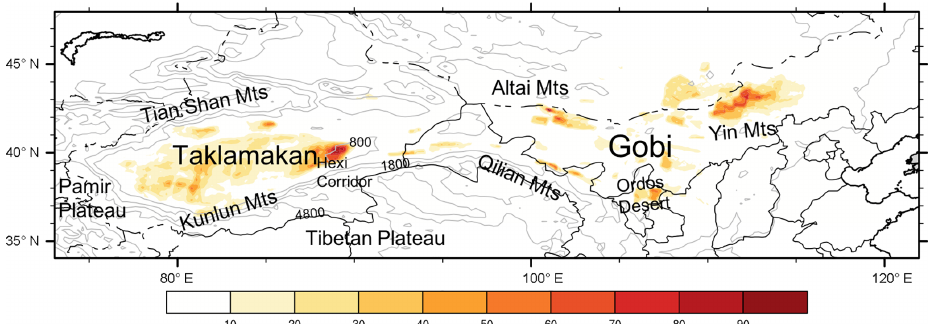
Figure 1. Spatial distribution of dust plume detection frequency (% sample maximum) according to MINX. Grey contours indicate surface elevation (m) from the Multi-angle Imaging SpectroRadiometer (MISR) digital elevation model (DEM). Dust plume detection frequency in each pixel is calculated as the number of detected dust plume points per